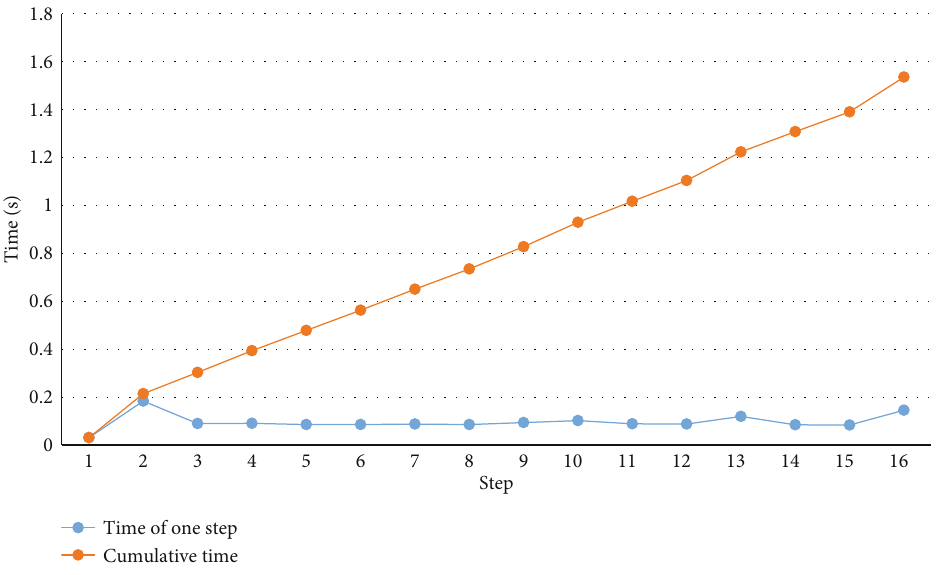
Figure 9: Time consumption in each step of the coalescence processing.